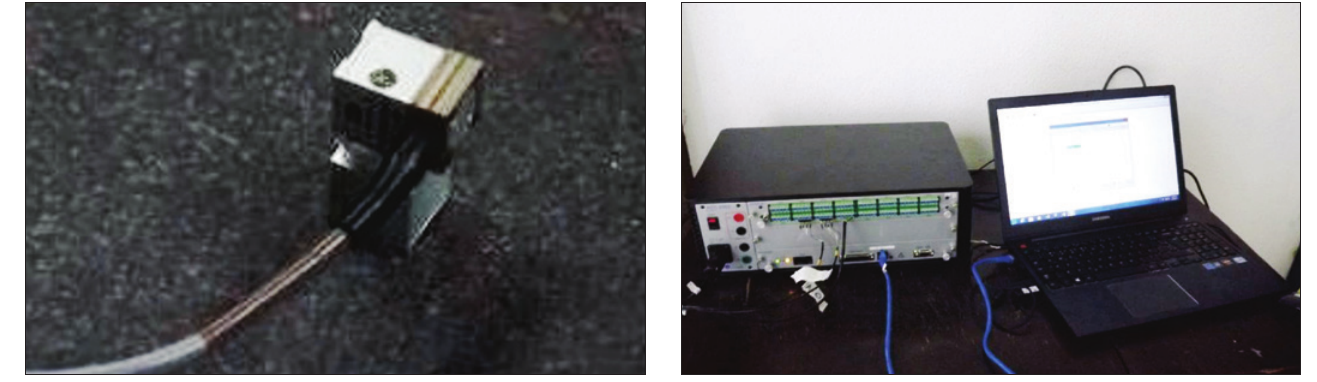
(a) Accelerometers Dytran (b) ADS-2002 system and